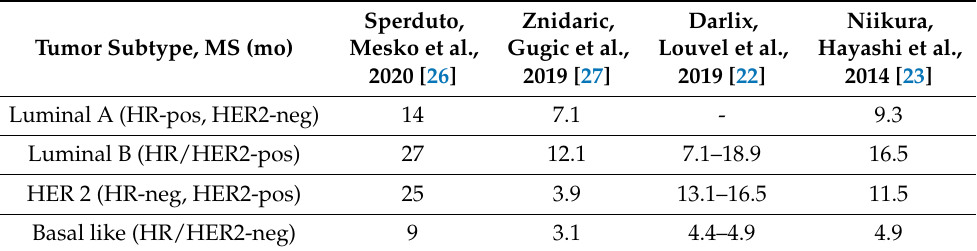
Table 2. Median survival (MS) of brain metastatic breast cancer patients, including biological subtypes qualified to radiotherapy according to breast GPA (Graded Prognostic